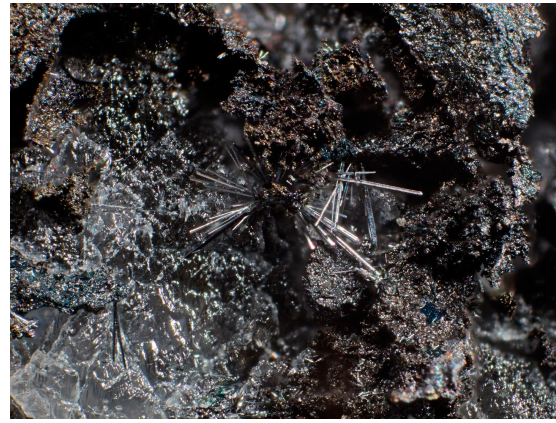
Figure 3. Antimonselite prismatic crystals partly etched from calcite. Field of view (FOV) 2.0 mm. Photo by P. Škácha.